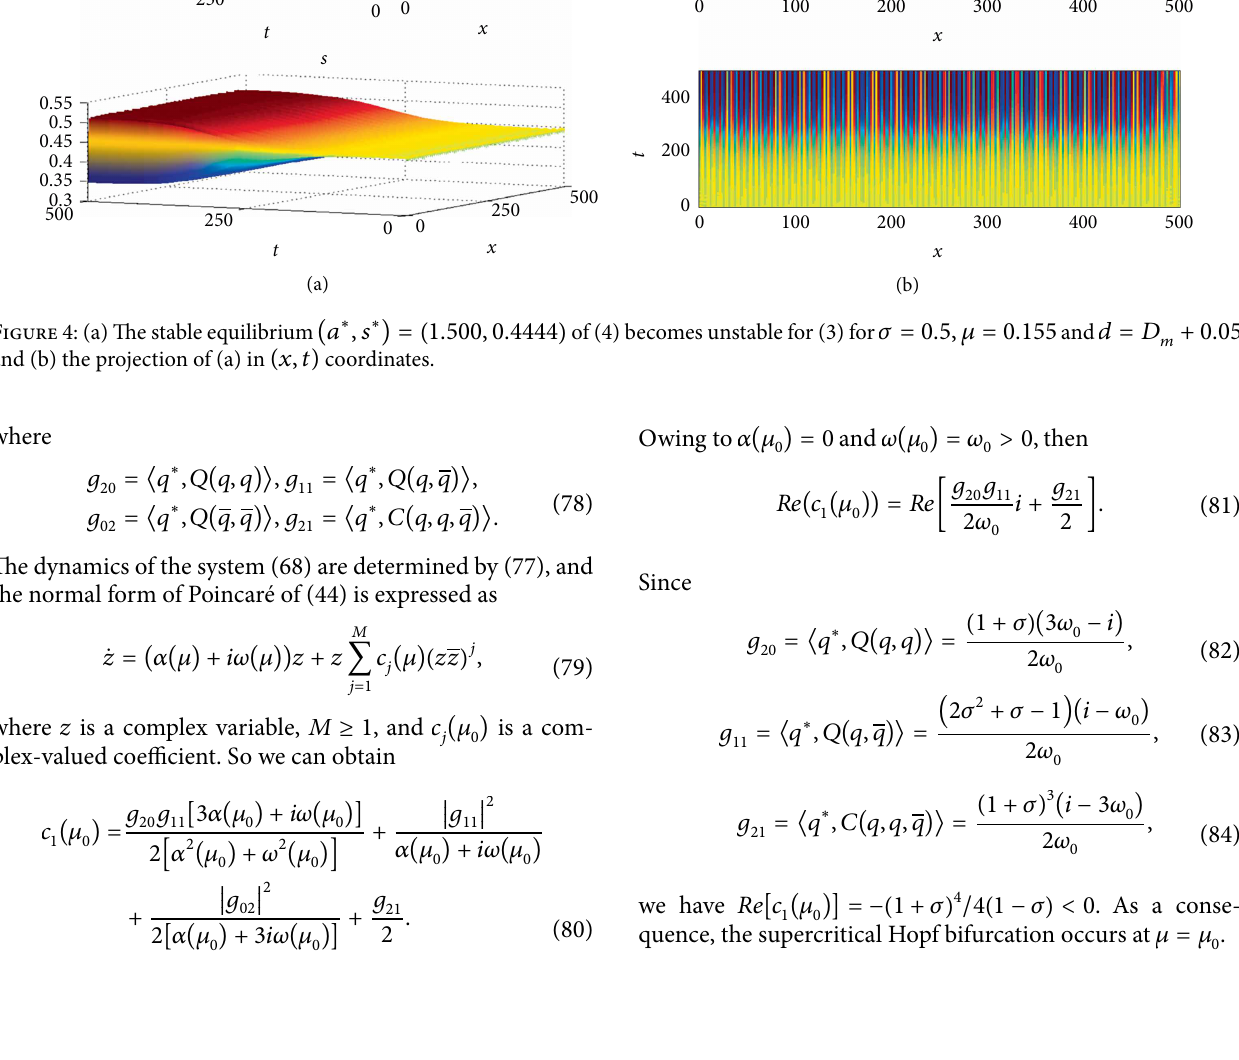
∗ ∗ ( 𝑎 , 𝑠 ) = (1.500, 0.4444) coordinates. (𝑥, 𝑡)